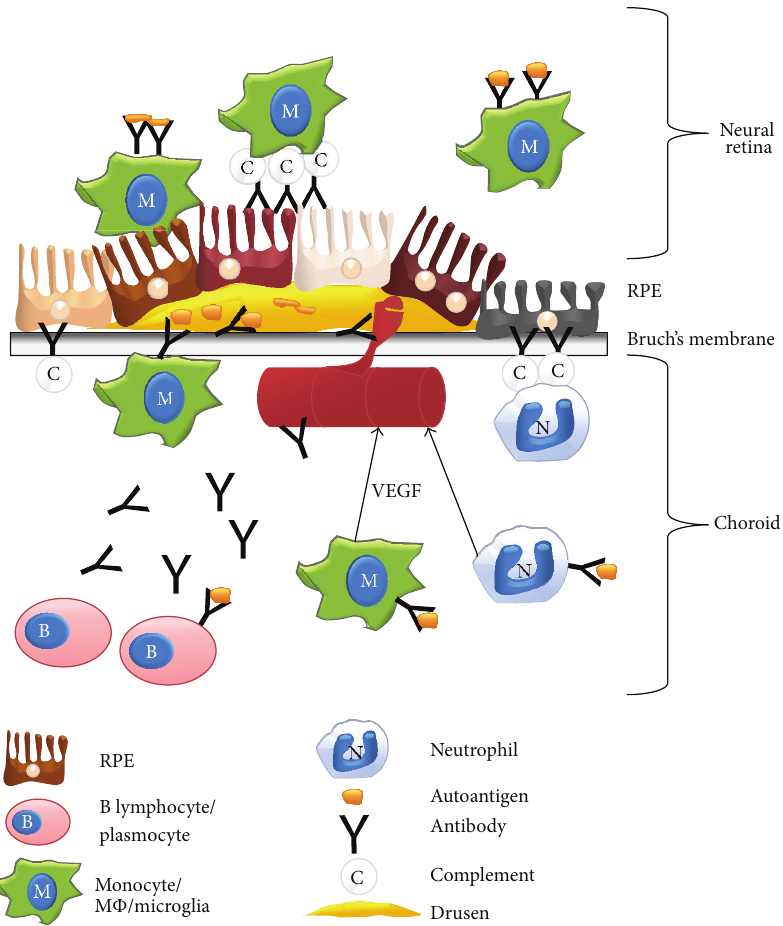
Figure 1: Potential mechanisms of action of autoantibodies in AMD. Classical activation of complement pathway by autoantibodies produced by autoreactive plasmocytes could destroy directly RPE. In addition, autoantibodies could recruit, activate, and induce RPE phagocytosis by macrophages and neutrophils in a complement dependent or independent manner. Moreover, autoantibodies could induce choroidal vessels involution by inhibiting vessel growth or in contrary enhancing choroidal neovascularization by inducing proangiogenic factors production by macrophages and neutrophils. VEGF: vascular endothelial growth factor; RPE: retinal pigmented epithelium; location of the neural retina is mentioned but not